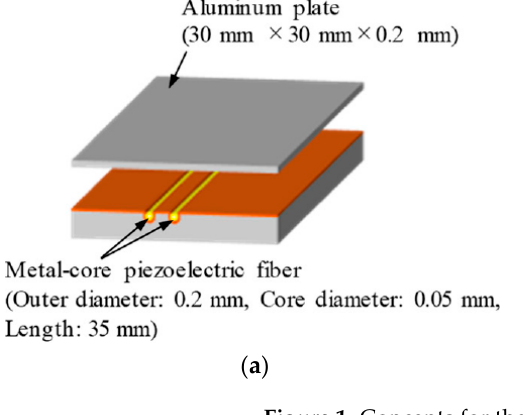
Figure 1. Concepts for the application of piezoelectric transducers without adhesive layers; ( a ) In- terphase forming/bonding of piezoelectric elements with round cross-section and metal core [27]; ( b ) Integration of piezoelectric elements with rectangular cross-section by joining by forming [29].